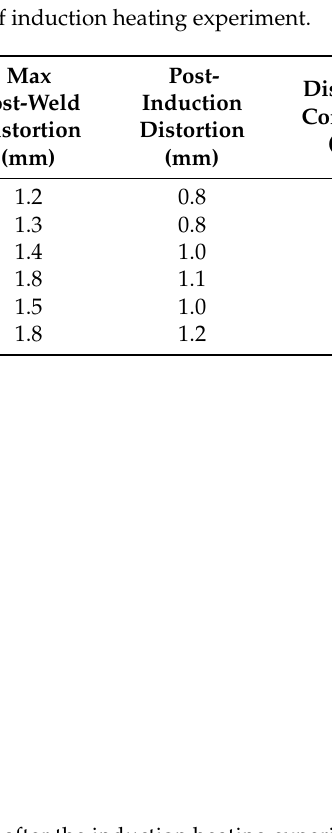
Figure 6. The experimental process for induction heating.